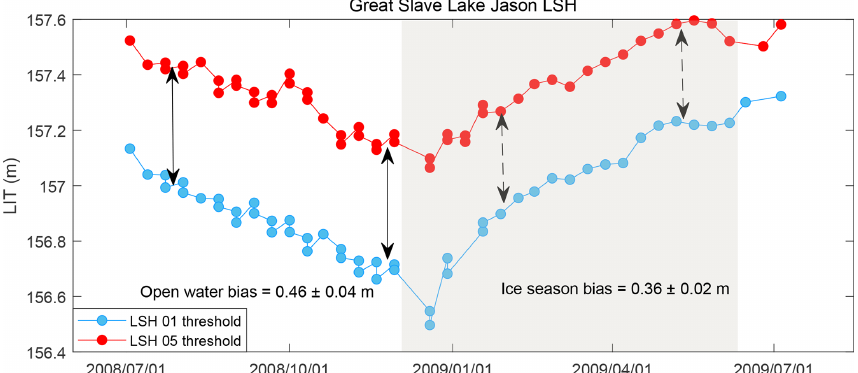
Figure 12. Different systematic biases between the LSH based on the 0.1 threshold and the 0.5 threshold in different seasons. Red and blue curves denote original LSH based on the 0.1 threshold and the 0.5 threshold in GSL during 2008–2009. The gray shade represents the ice-covered